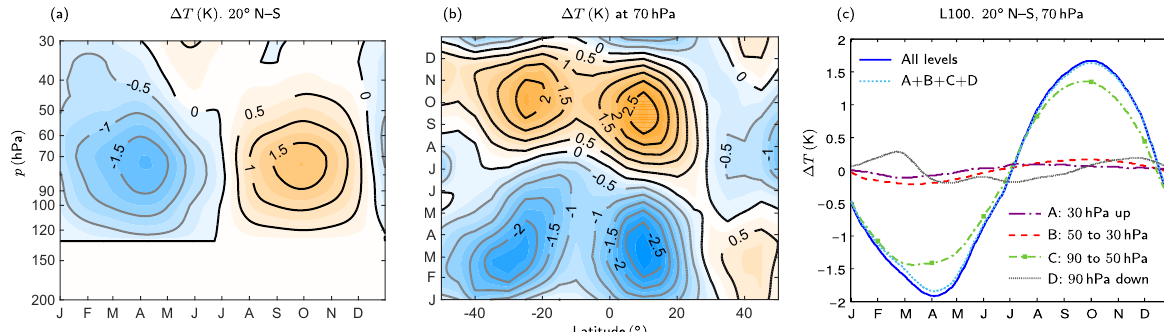
Figure 3. SEFDH temperature change (K) due to the annual cycle in ozone. All other trace gases are kept at their annual mean values. (a) Temperature change averaged between 20 ◦ N and 20 ◦ S. (b) Temperature change at 70hPa. (c) Temperature changes at 70hPa and averaged between 20 ◦ N and 20 ◦ S calculated with the annual cycle in ozone imposed within different pressure ranges. Outside of each range and including the pressure level at the lower bound (in terms of height) of the range, the ozone mixing ratio is kept at the annual mean